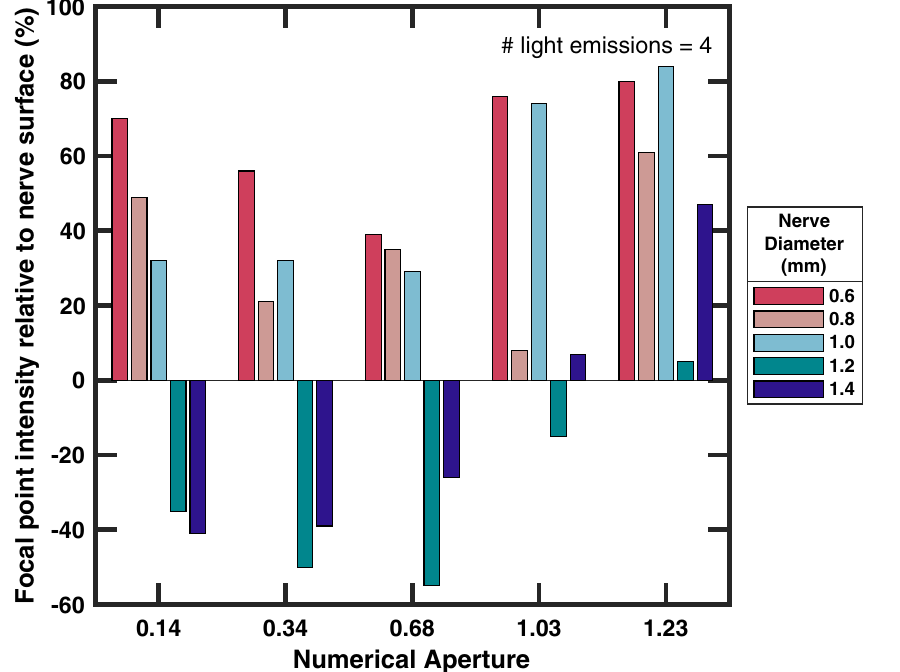
Figure 4. Relative intensity of the focal point to the nerve’s surface as a function of focal power. Focal power is represented by the NA of the lens to provide the angle of focus. The intensity of the nerve surface for each simulation was normalized to 0 with the focal point’s change given as a